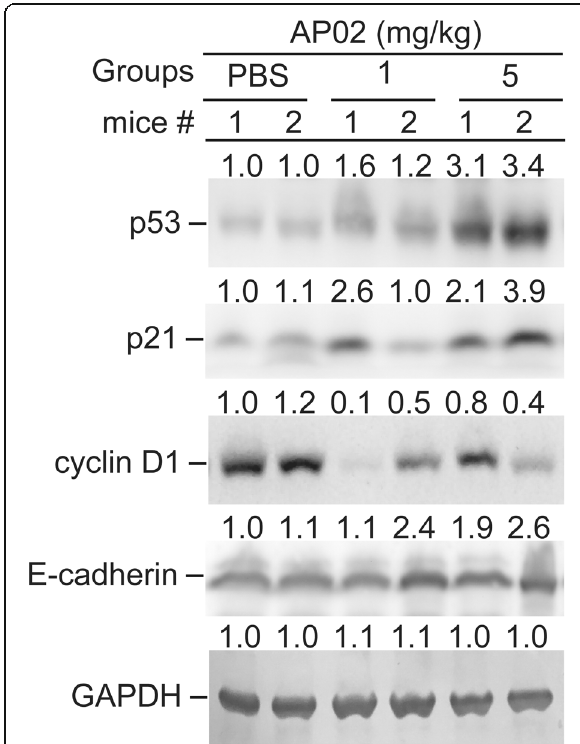
Fig. 7 Effect of AP-02 on expression of G0/G1 phase regulatory and metastasis-related proteins in COLO 205 xenograft tumor tissues. Tumor tissues were dissected to isolate protein lysate extracts. Protein extracts (100 μ g per lane) were separated via SDS-PAGE. After electrophoresis, proteins were transferred onto Immobilon-P membranes, which were probed with the proper dilution of specific antibodies. Proteins were then detected using the NBT/BCIP